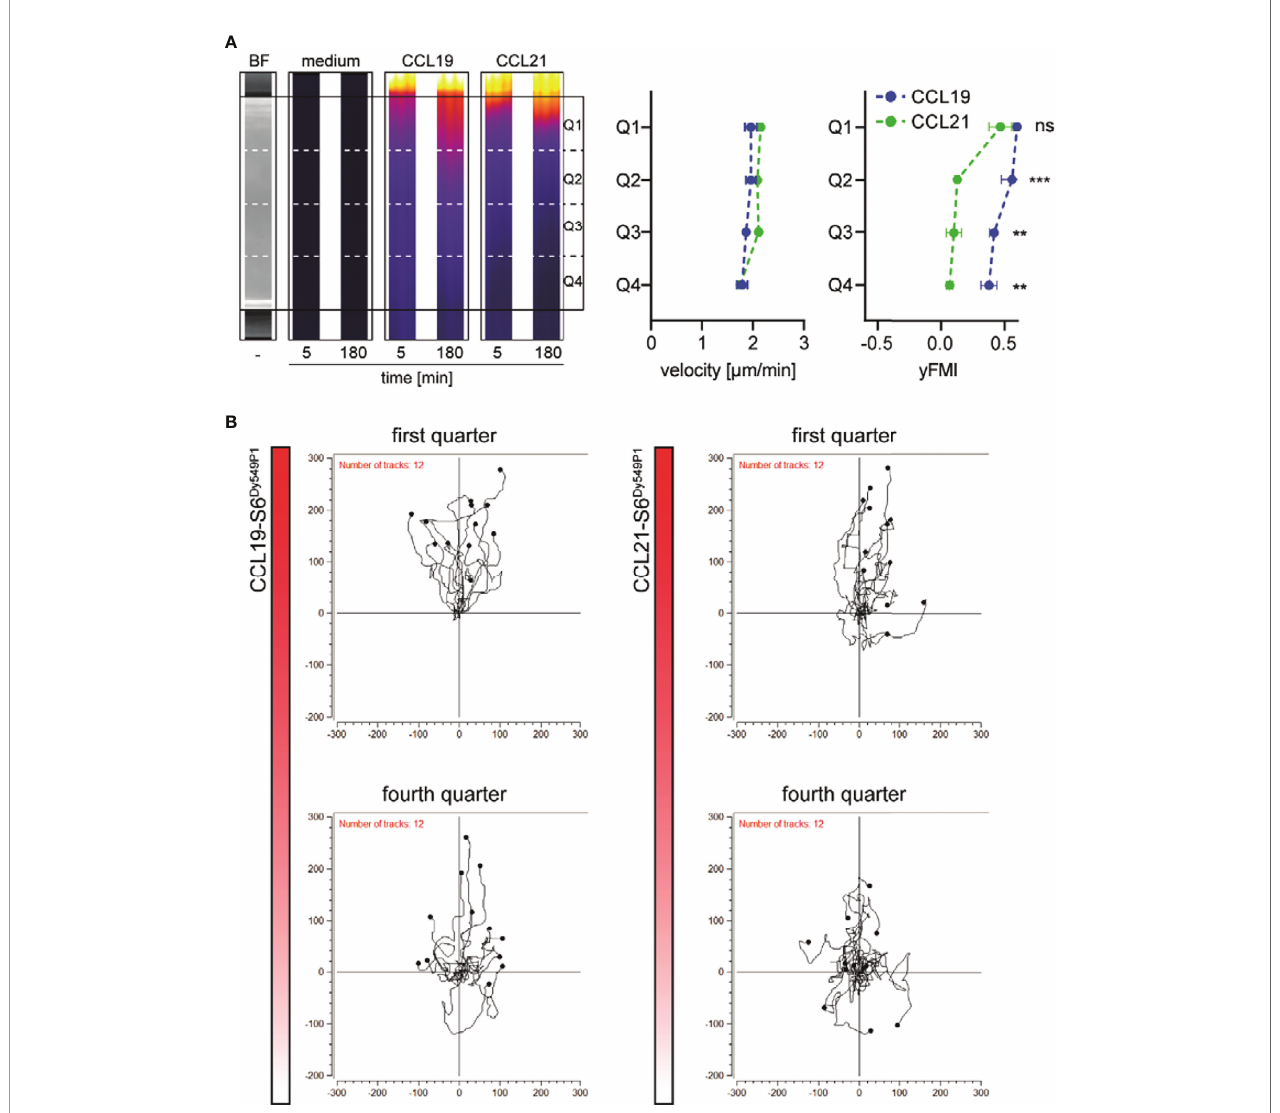
FIGURE 3 | Distinct shapes of CCL19 and CCL21 gradients translate into different migratory responses of human DCs. (A) Representative cropped microscopic images of the central 3D migration chamber. Bright fi eld (BF) as well as pseudocolored fl uorescence images of medium, CCL19-S6 Dy549P1 and CCL21-S6 Dy549P1 at indicated time points derived from one out of three independent experiments are shown (left panel). Velocity and forward migration index in the y-axis (yFMI) of human matured MoDCs migrating along the chemokine gradients in each quarter are shown in the right panel. Mean values ± SD for n = 3, statistical analysis: two- way ANOVA with Sidak post-test. (B) Spider plots of individual tracks of migrating MoDCs in quarters Q1 and